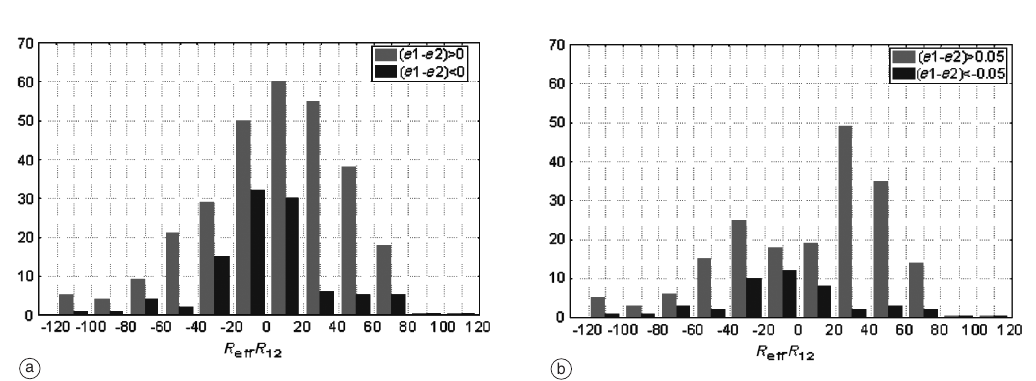
Fig. 3.6a,b. Distribution of ( R eff − R 12 ), for the cases when SIRMUP performs better than SIRM (pale grey) and when SIRMUP performs worse than SIRM (dark grey): a) for all cases; b) only for those cases where the dif- ference in the relative errors e 1 and e 2 exceed 0.05.